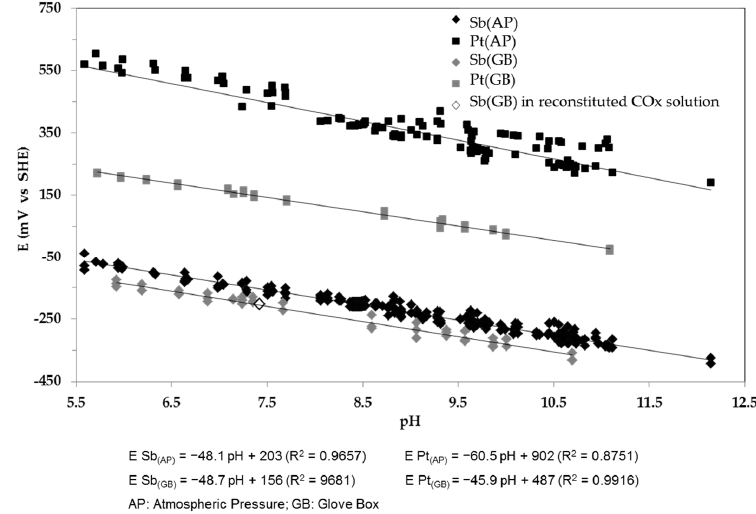
Figure 8. Comparison of calibration curves obtained from antimony (Sb(s) and Sb(SPEs)) and platinum electrodes obtained at 25 °C, under atmospheric pressure and in the glove box. An antimony potential value (vs. SHE) representing the average potential of the electrode in the reconstituted COx solution over one month was added.